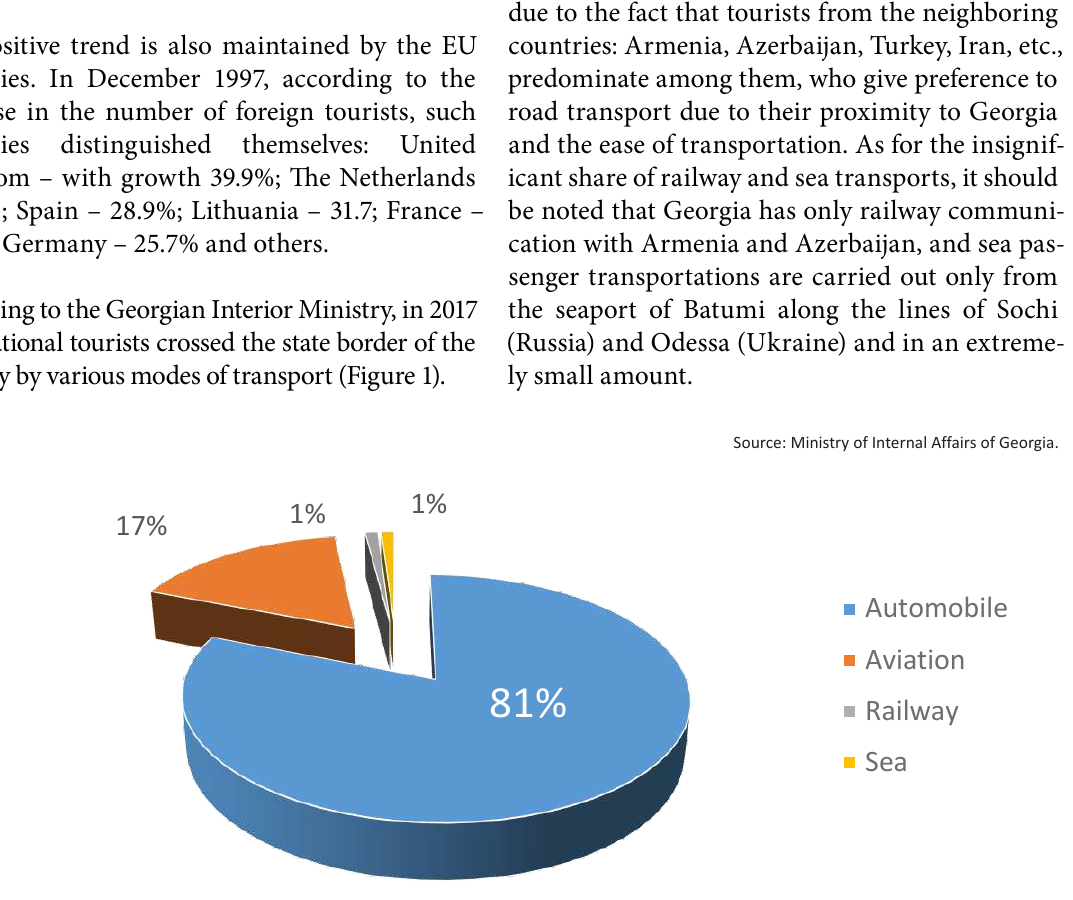
Figure 1. The diagram of crossing the Georgian border by various modes of transport